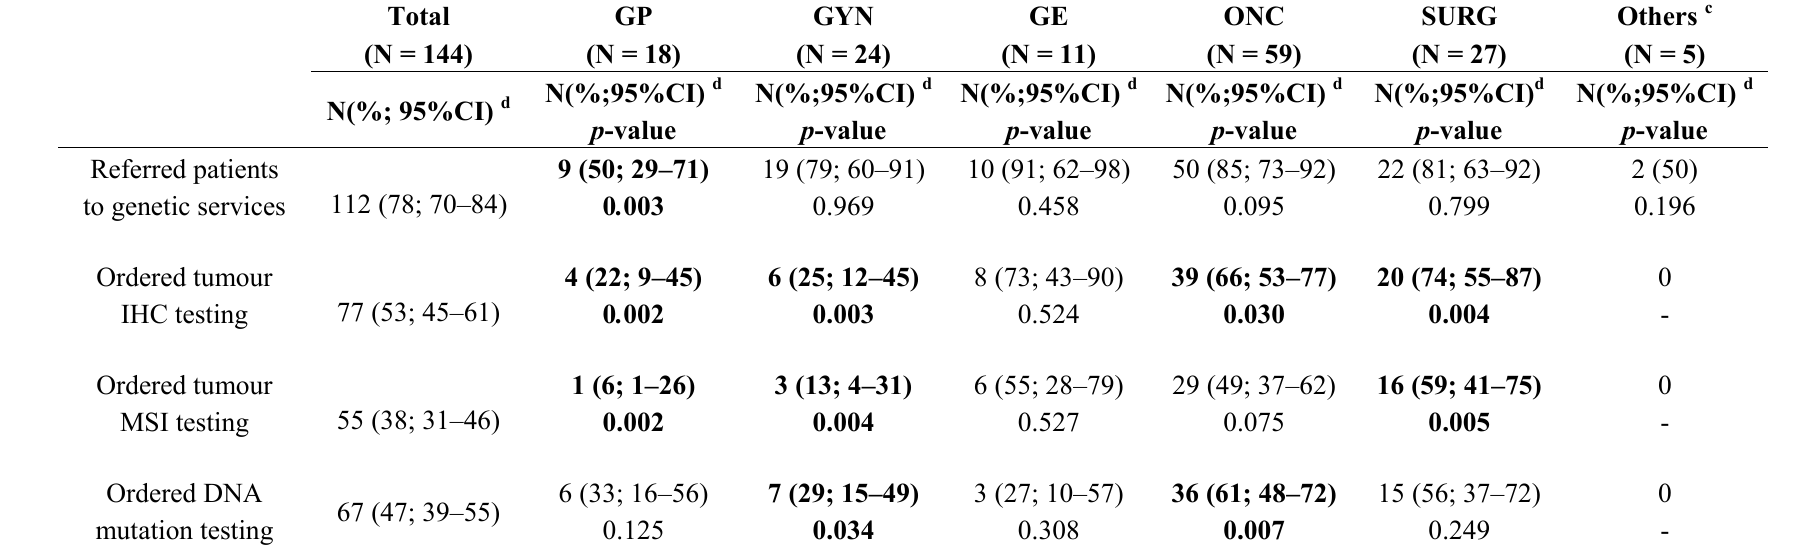
Table 2. Likelihood that clinicians reported referring patients to clinical genetic services or ordering tumour analysis in the past 12 months, by provider group a,b